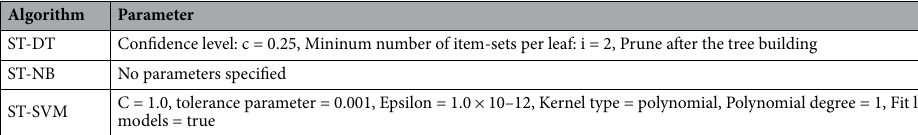
Table 5. Parameter specification for all the base-learners used in the self-learning baseline used in the experimentation.